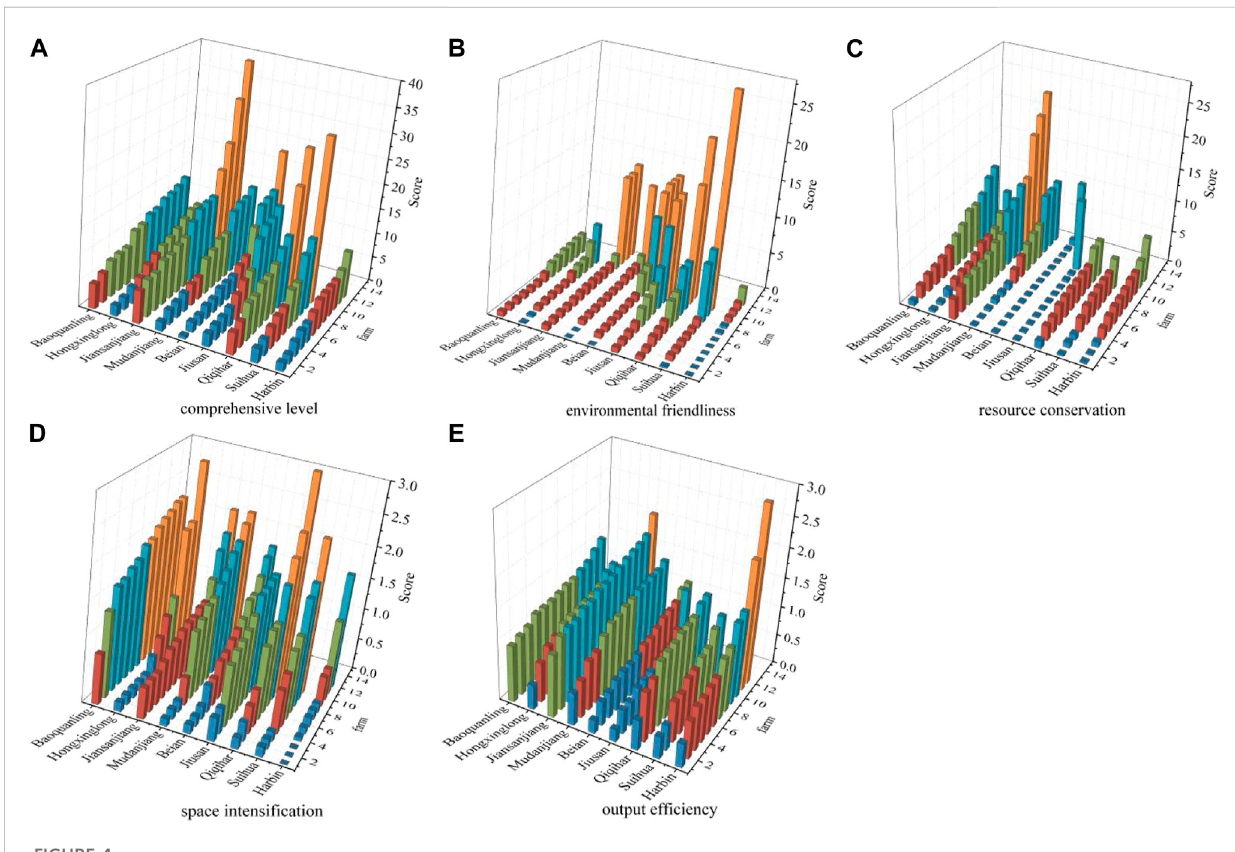
FIGURE 4 GUL-CL in heilongjiang reclamation